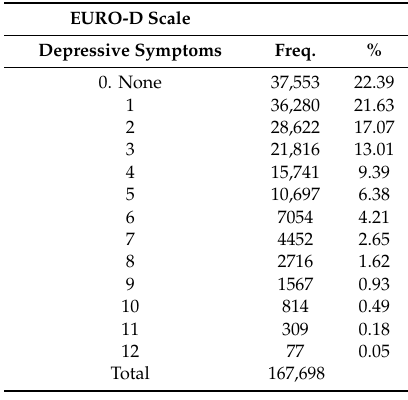
Table A3. Depressive symptoms (frequency and